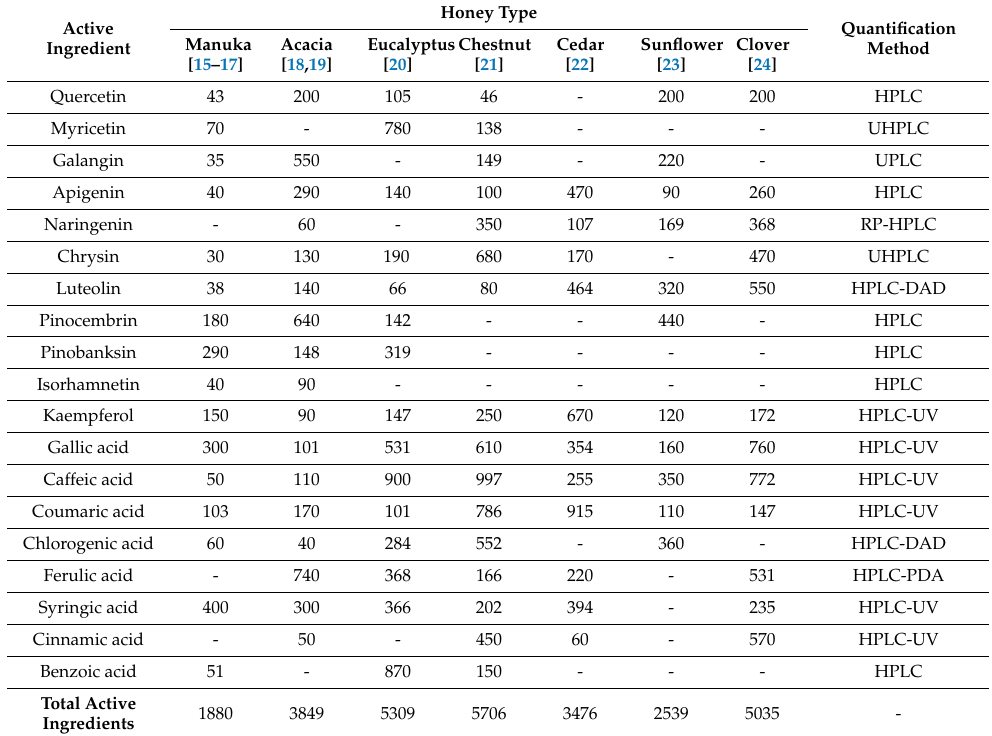
Table 1. Quantity ( µ g/kg) of Different Polyphenols in Various Types of